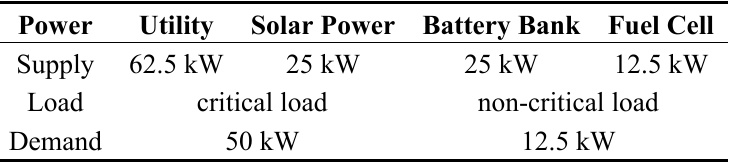
Table 1. The setting of each power and load.